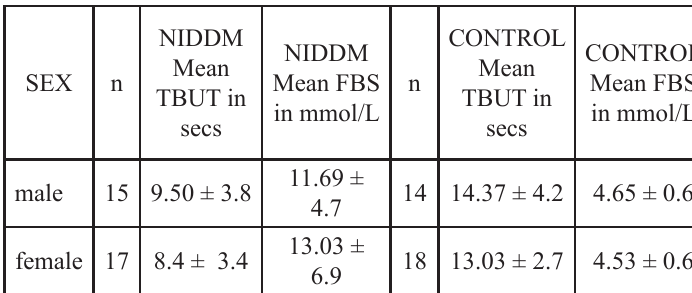
Table 2: Mean TBUT for males and females in both NIDDM and control groups and mean FBS for both males and females in the NIDDM group.